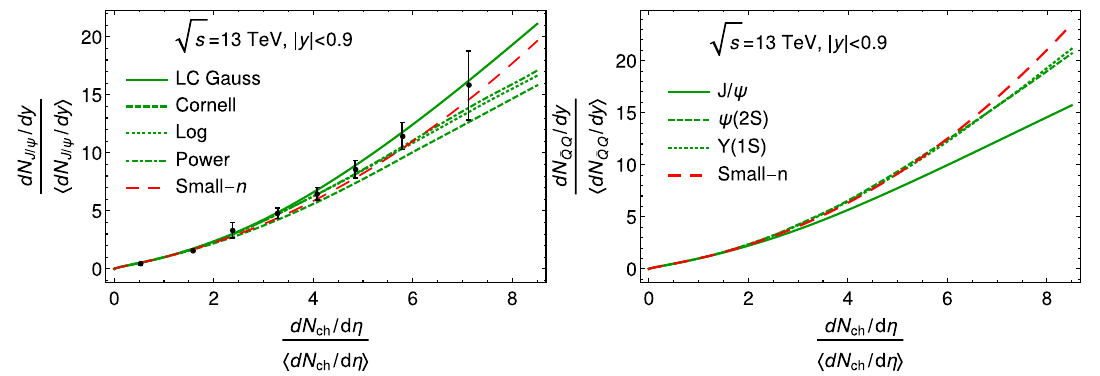
Fig. 7 Left: dependence of the ratio (17) on the choice of wave func- tion. The solid line corresponds to evaluation with the light-cone Gauss WF.Thedashedanddottedlinescorrespondtoevaluationswithboosted rest frame wave functions introduced in Appendix B. The experimental data are from [26,62]. Right: comparison of J /ψ results with predic-